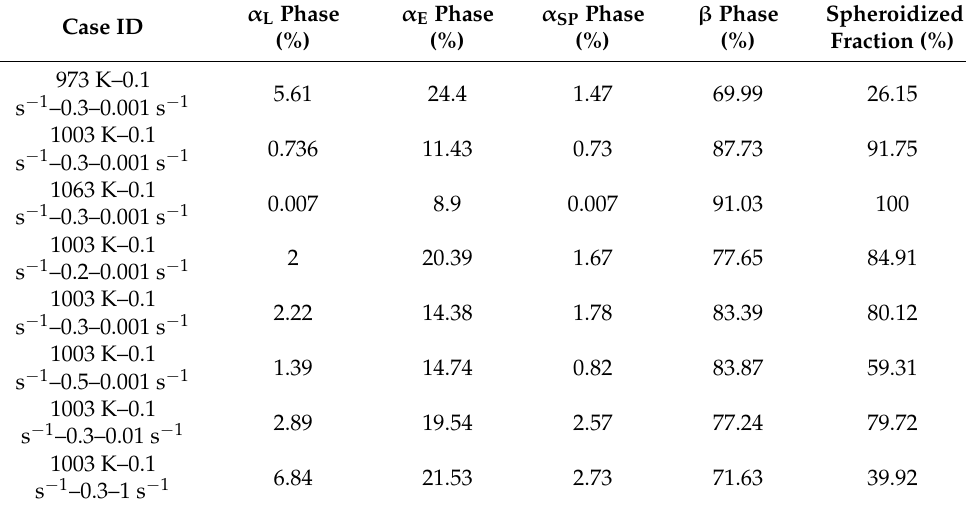
Table 2. The volumes fraction of α E , α L , α SP , β phases and spheroidization fraction (%). Case